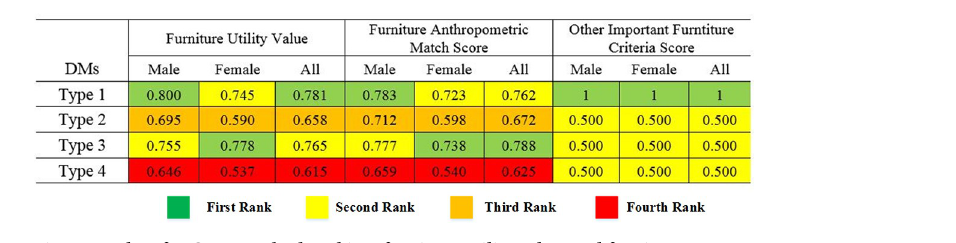
Fig 9. Results of MCDM method ranking, furniture utility value, and furniture scores.